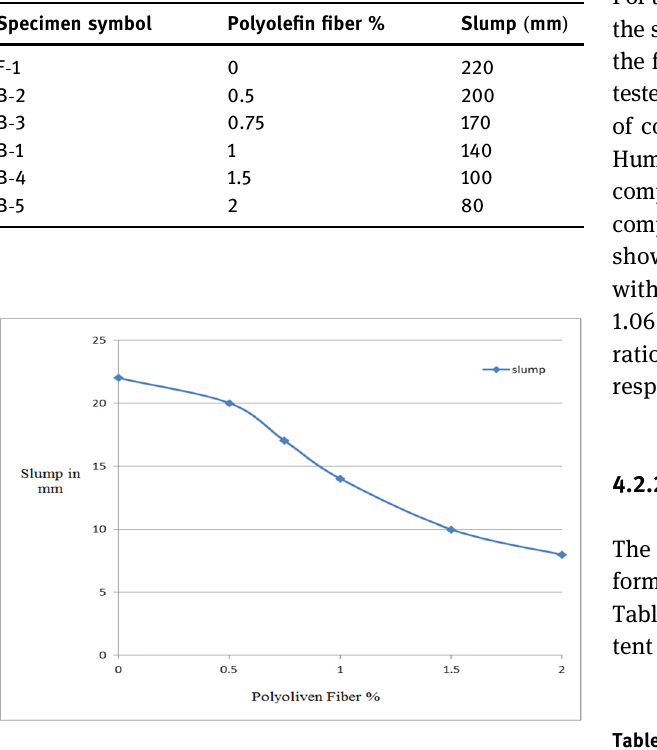
Figure 5: Slump of fresh concrete containing polyole fi n percent in di ff erent mixes.